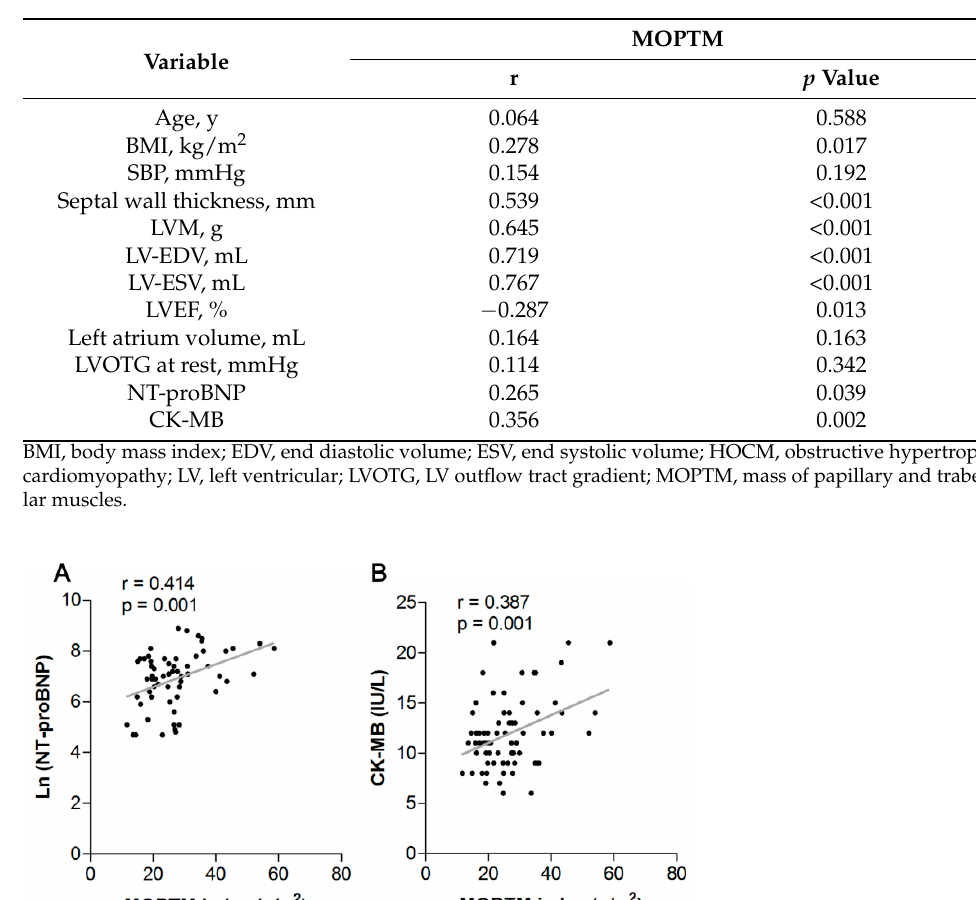
Table 3. Correlation between indices measured with the conventional method and the MOPTM of patients with HOCM.